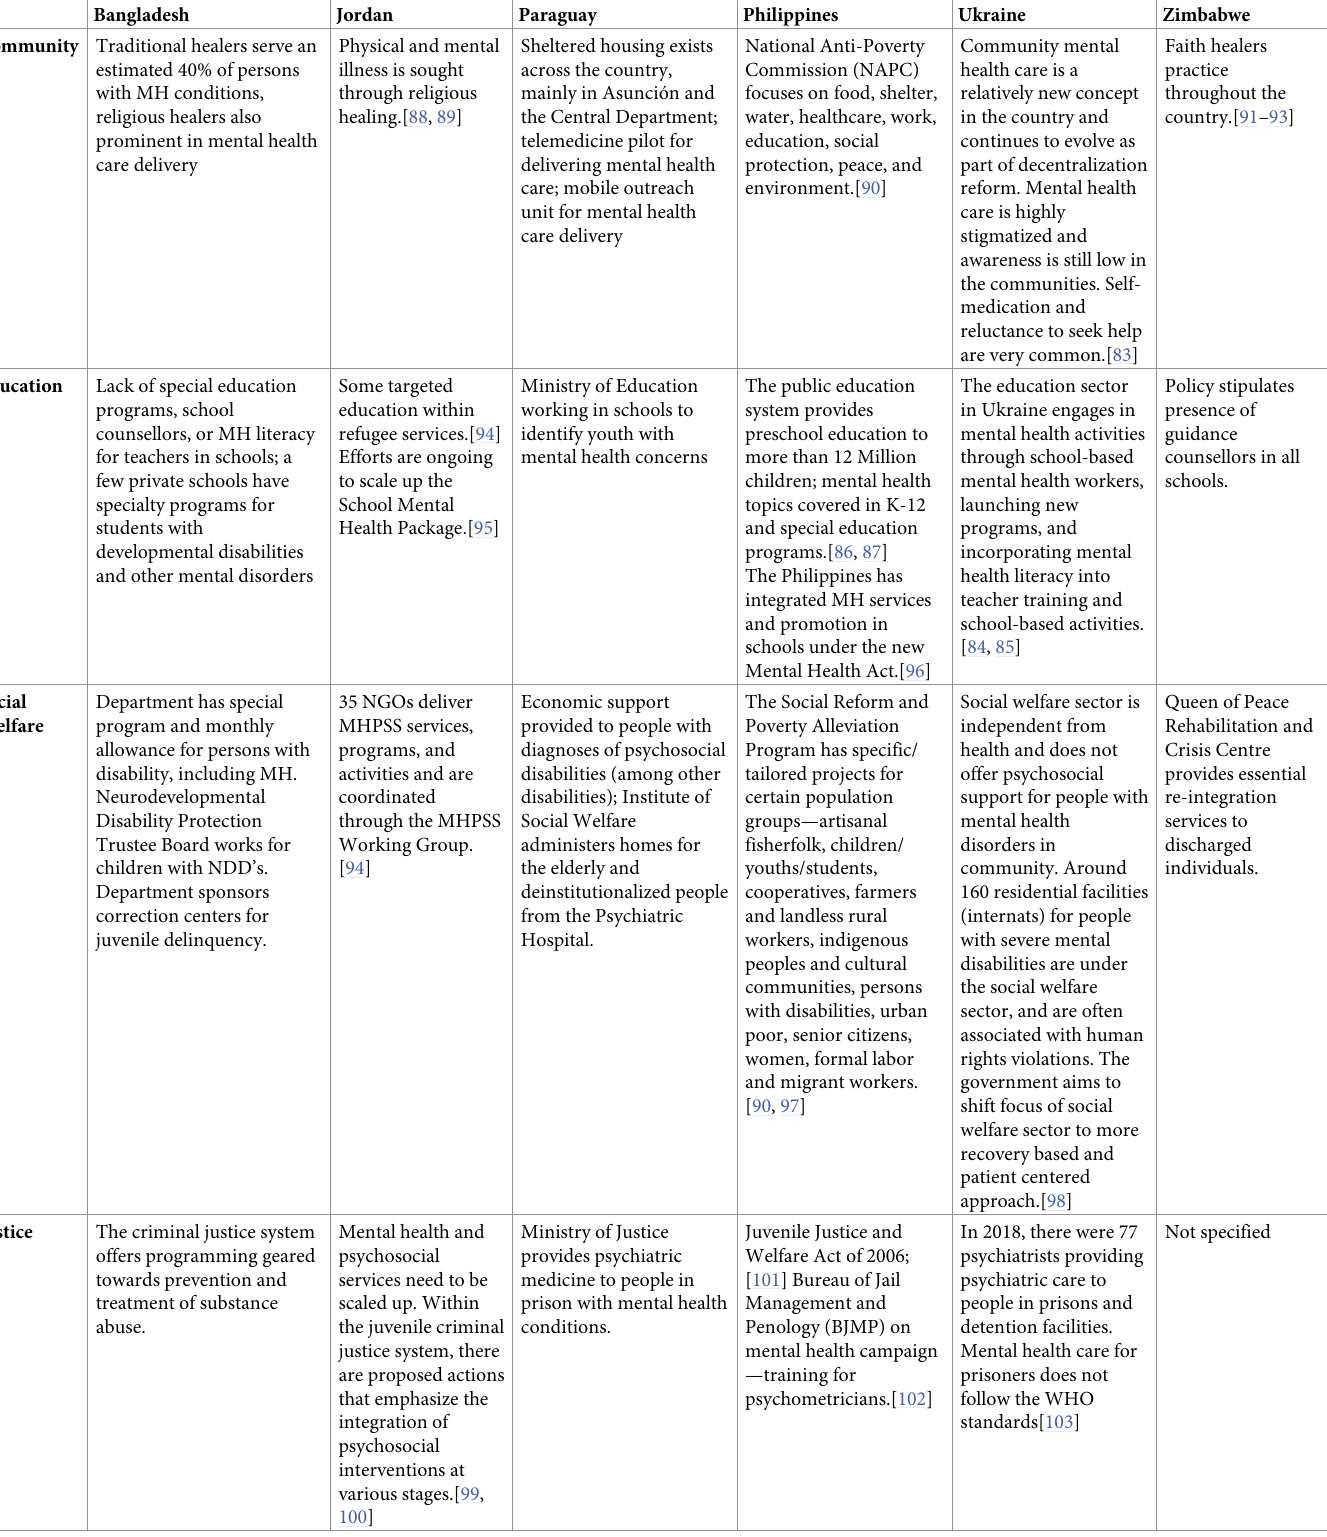
Table 6. Non-health sector mental health